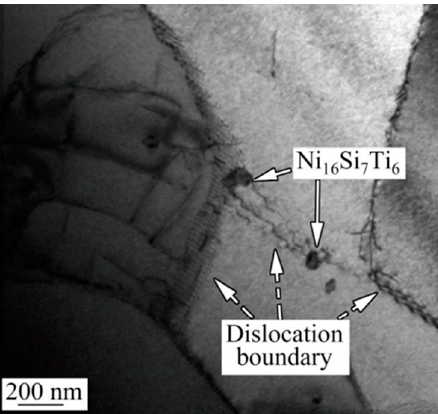
Figure 7. TEM image of Ni 16 Si 7 Ti 6 particles and the dislocation boundary [35] .